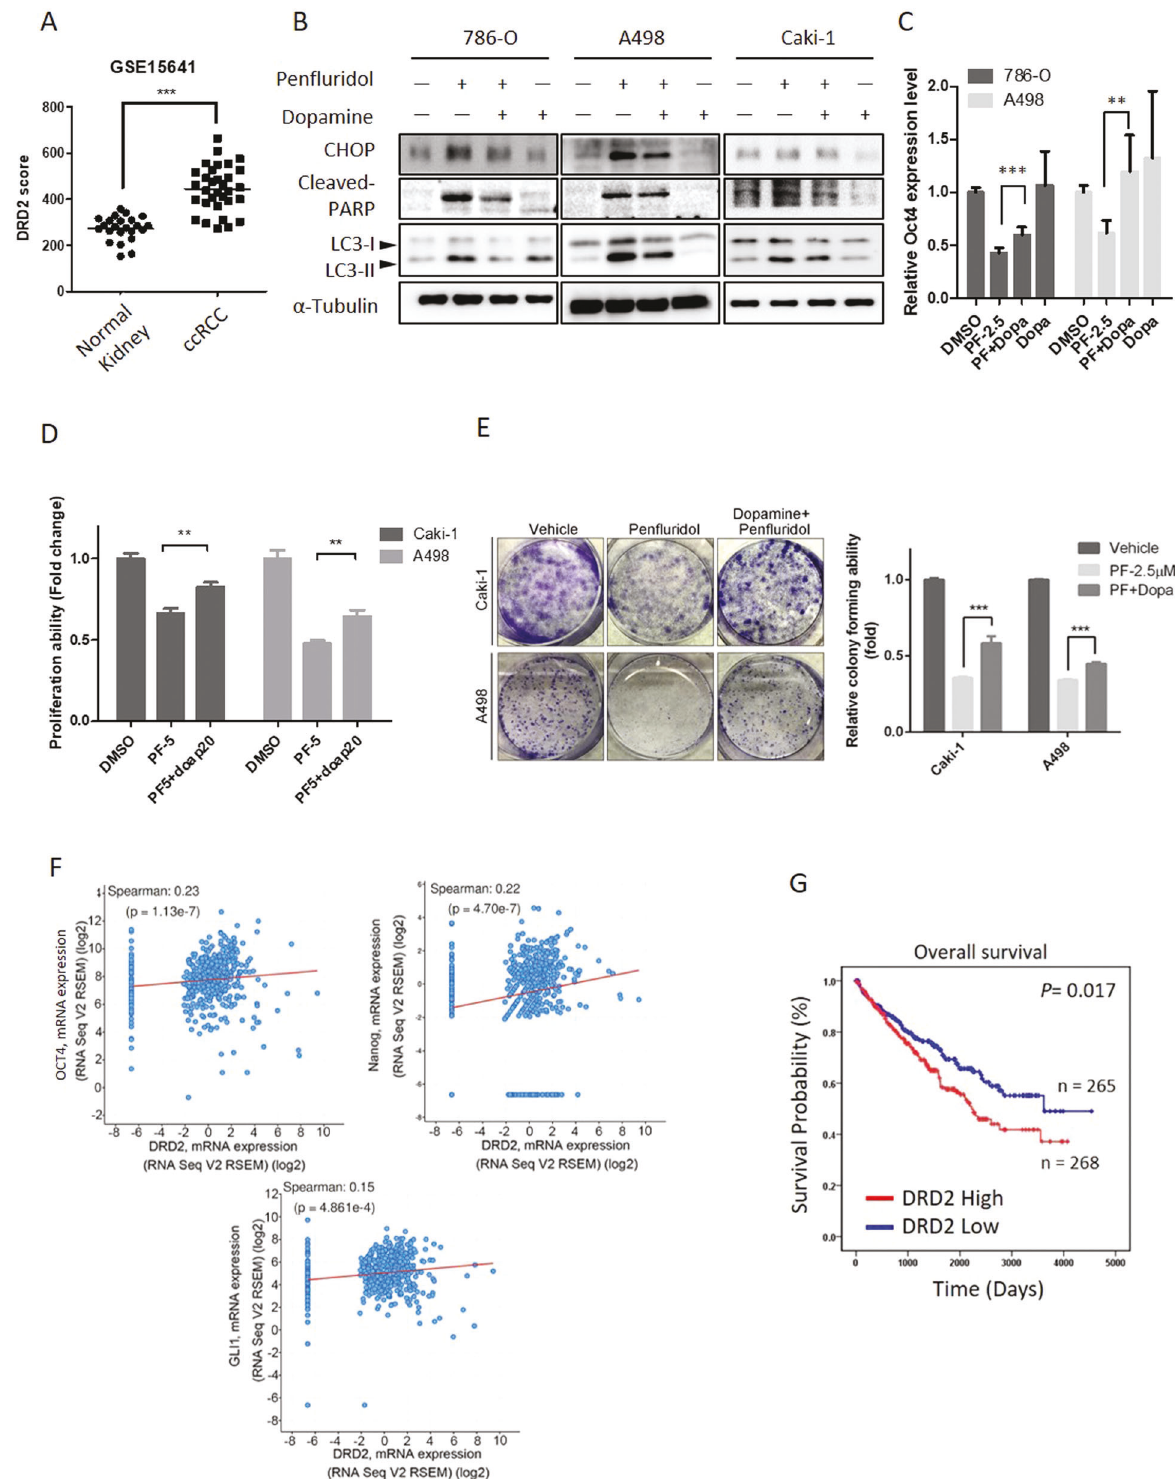
pathway leading to higher calcium levels and elevated ER stress, thus inducing apoptosis [17]. In addition to pancreatic cancer, He et al. showed that EGF receptor (EGFR) overexpression was associated with poor in vitro and in vivo responses to DRD2 antagonists [38], suggesting the mechanisms by which DRD2 signaling contributes to cancer progression appeared